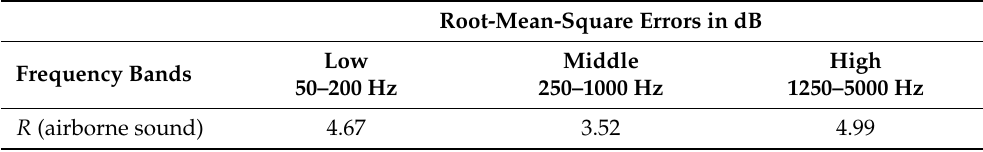
Table 4. Error distributions in the prediction of airborne sound reduction index R considering three frequency